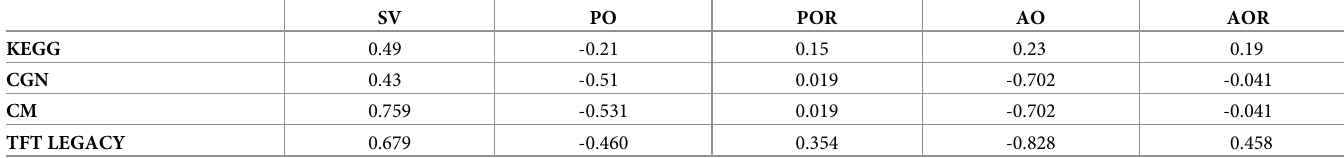
Table 2. Correlation among size and position in the rankings. Kendall’s τ coefficients measuring the correlation among the position in the ranking and the size of the gene sets.